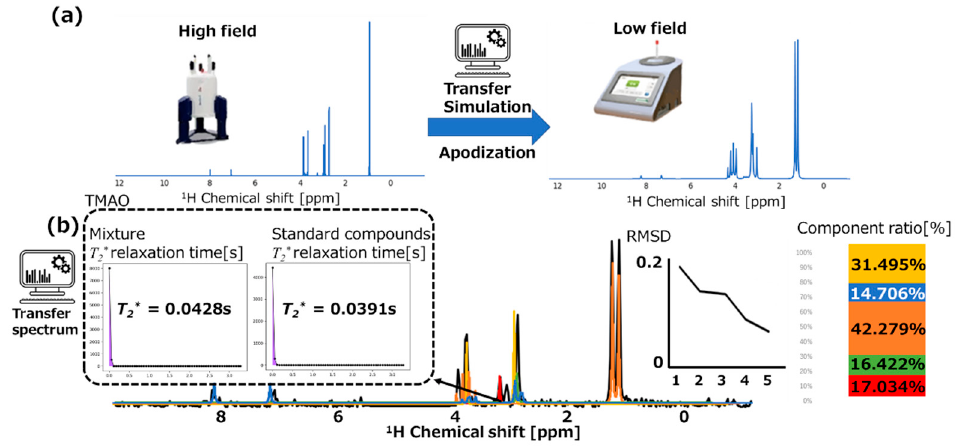
Figure 4. ( a ) High-field 1 H-NMR spectra before and after the data transfer simulation. ( b ) Assignment results and root-mean-square deviation values of spectra for standard compounds, which were transferred to the corresponding compounds in the food mixtures (tuna) analyzed by benchtop low-field NMR. Red, green, orange, blue, and yellow represent the spectrum and component ratio of choline, TMAO, lactate, histidine, and creatine, respectively. Calculated representative T 2 * relaxation times are displayed for TMAO in the food mixture and its standard compound.